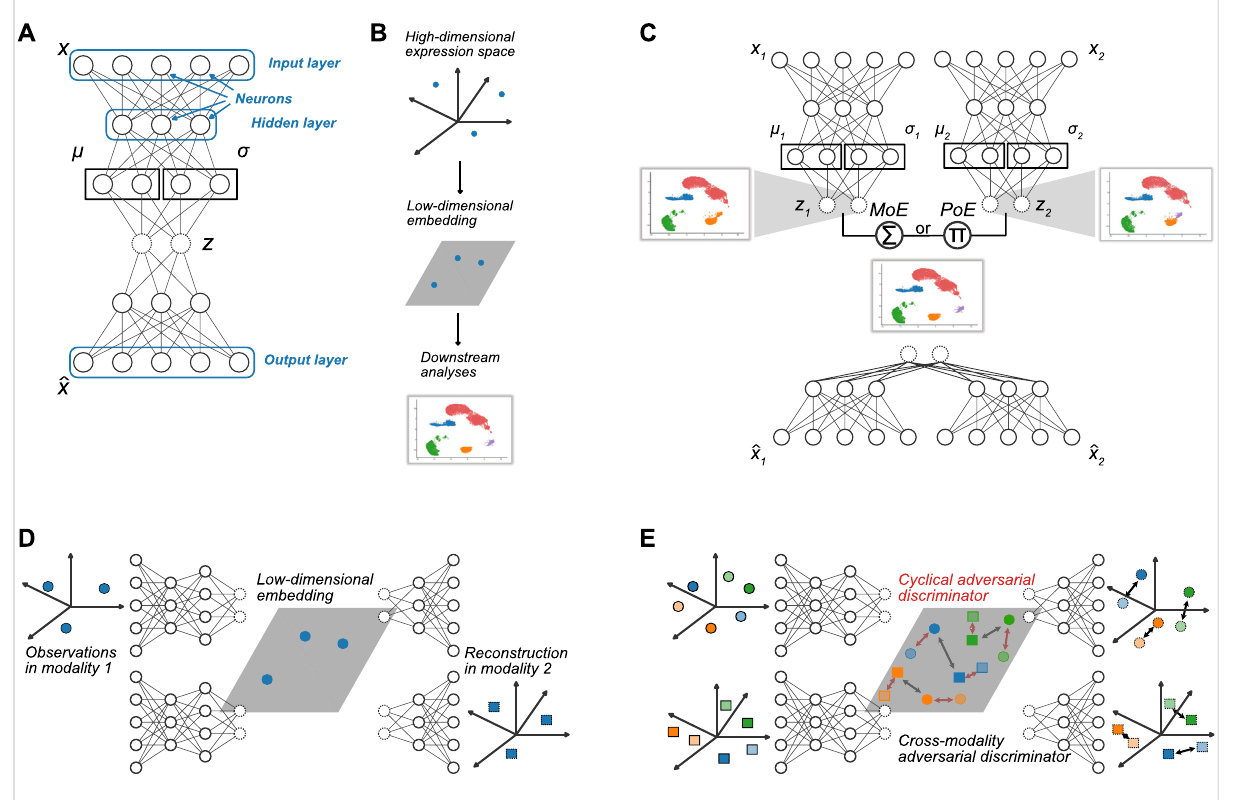
FIGURE 1 Neural network architectures. (A) Exemplary network architecture of vanilla VAE, where x represents the input data and ^ x is the reconstructed data. Random variables z in the bottleneck layer are indicated by dashed circles. μ and σ represent the mean and standard deviation of the distributions, typically Gaussian distributions with diagonal covariance matrices, learned in the bottleneck layer. (B) Typical work fl ow: High- dimensional omics data are mapped to a low-dimensional embedding, which can then be utilized for visualization and downstream analyses such as clustering or trajectory inference. (C) General architecture of multimodal VAEs. (D) Cross-modality translation: High-dimensional measurements from one modality are mapped to a low-dimensional embedding with the modality-speci fi c encoder. The latent representation is thenused asinputfor thedecoderoftherespective othermodality. (E) Adversarial training principles: Adversarialdiscriminators canbeemployed(1) toalignlow-dimensionalembeddingsofdifferentmodalities(squaresvs.circles)ofthesamecell(samecolor)inthelatentspace(blackarrows),(2)to align reconstructed pro fi les with the cross-modal reconstructions (lighter colors) obtained by decoding low-dimensional embeddings of one modality with the decoder of the other modality (black arrows in the reconstruction space, or (3) to alignre-embedded decoder outputs from intra- modal and/or cross-modal reconstruction (lighter colors) with the original embeddings (red arrows in the latent